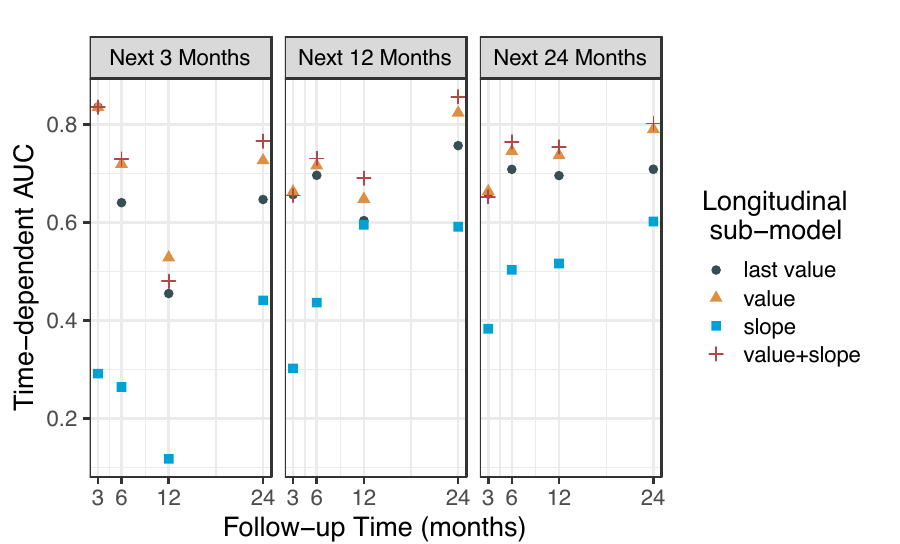
Figure 5. Time-dependent AUC under four different longitudinal sub-models in the joint model for time interval ( t , t + 3] (next 3 months, left panel), ( t , t + 12] (next 12 months, middle panel), and ( t , t + 24] (next 24 months, right panel) given the longitudinal LCP CNN scores to t = 3, 6, 12, and 24 months. The sub-model that includes the longitudinal LCP CNN scores plus the change rate performed the best among the four